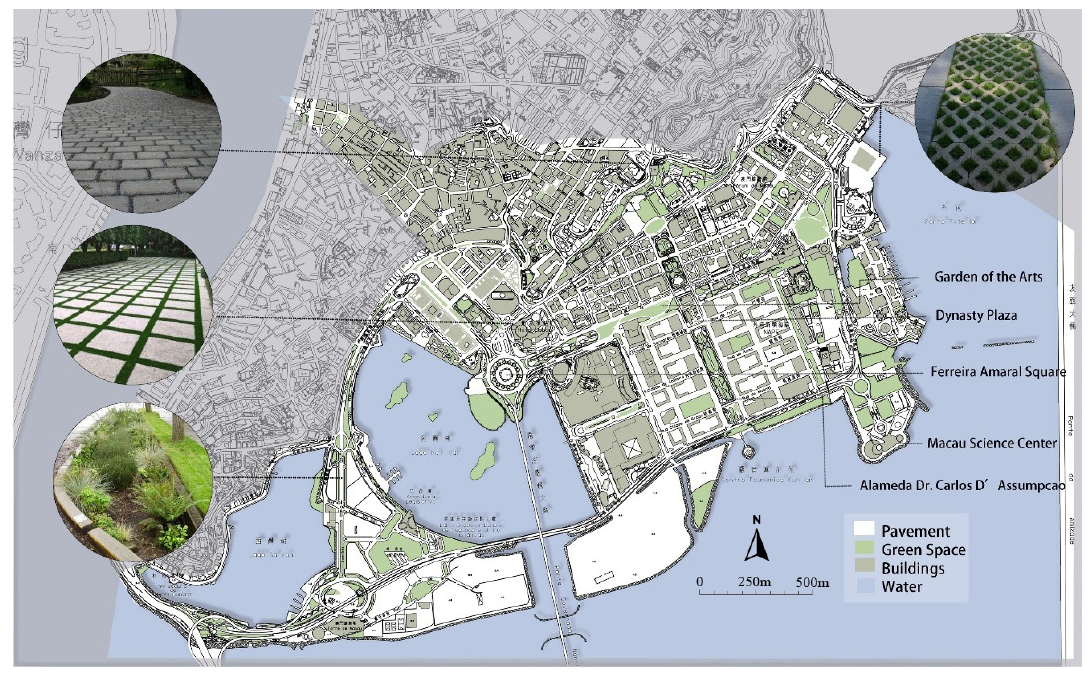
ff channels in Cathedral